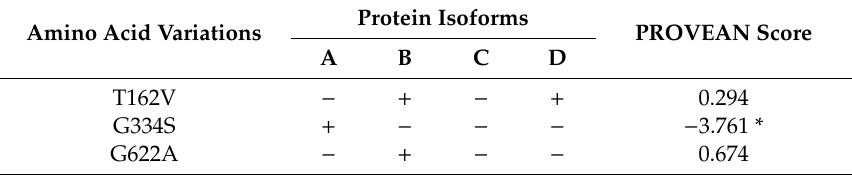
Table 2. Amino acid variations in the RHT-D1 protein of Ae. tauschii. Amino Acid Variations